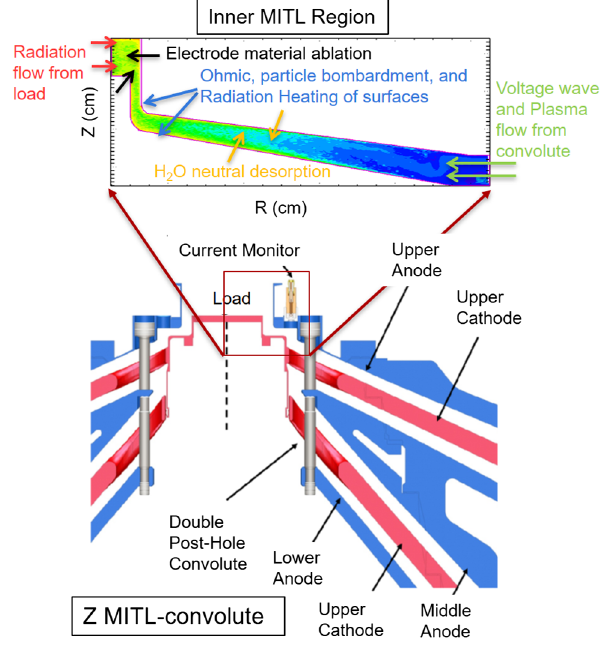
FIG. 1. A cylindrical ( r; z ) representation of the MITL-convolute system is shown. Power is delivered from four MITLs through a double-post-hole convolute to the load. An enlargement (top) of the radially converging inner MITL region is used to illustrate the physical processes which occur as power is delivered to a Z pinch. The voltage pulse and plasma generated upstream enter the inner MITL as shown on the right. The physical processes mapped by region are upstream charged particle flow, contaminant desorption, and ablation of material from the electrodes heated by Ohmic dissipation, charged particles, and